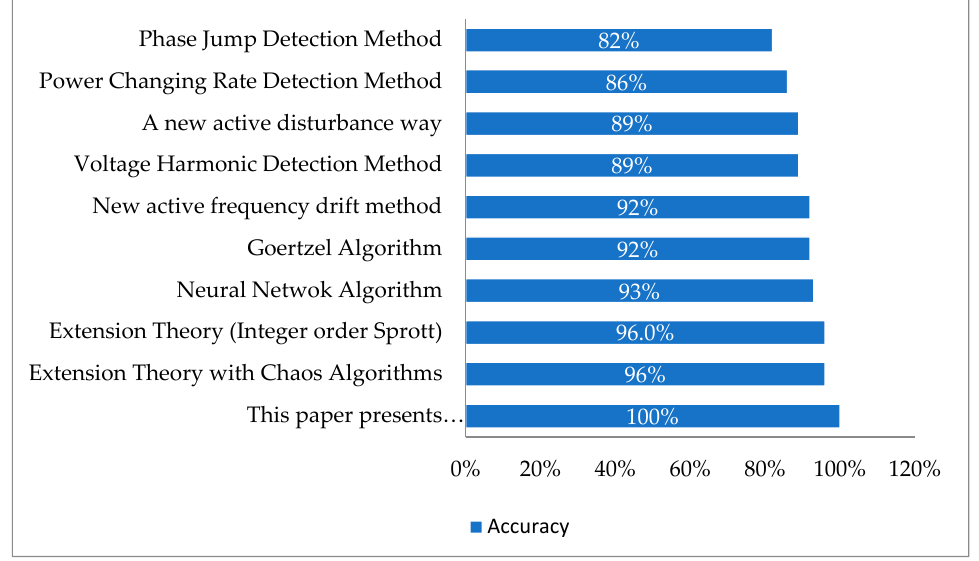
Figure 12. Accuracy comparisons between traditional methods and the method proposed in this paper.